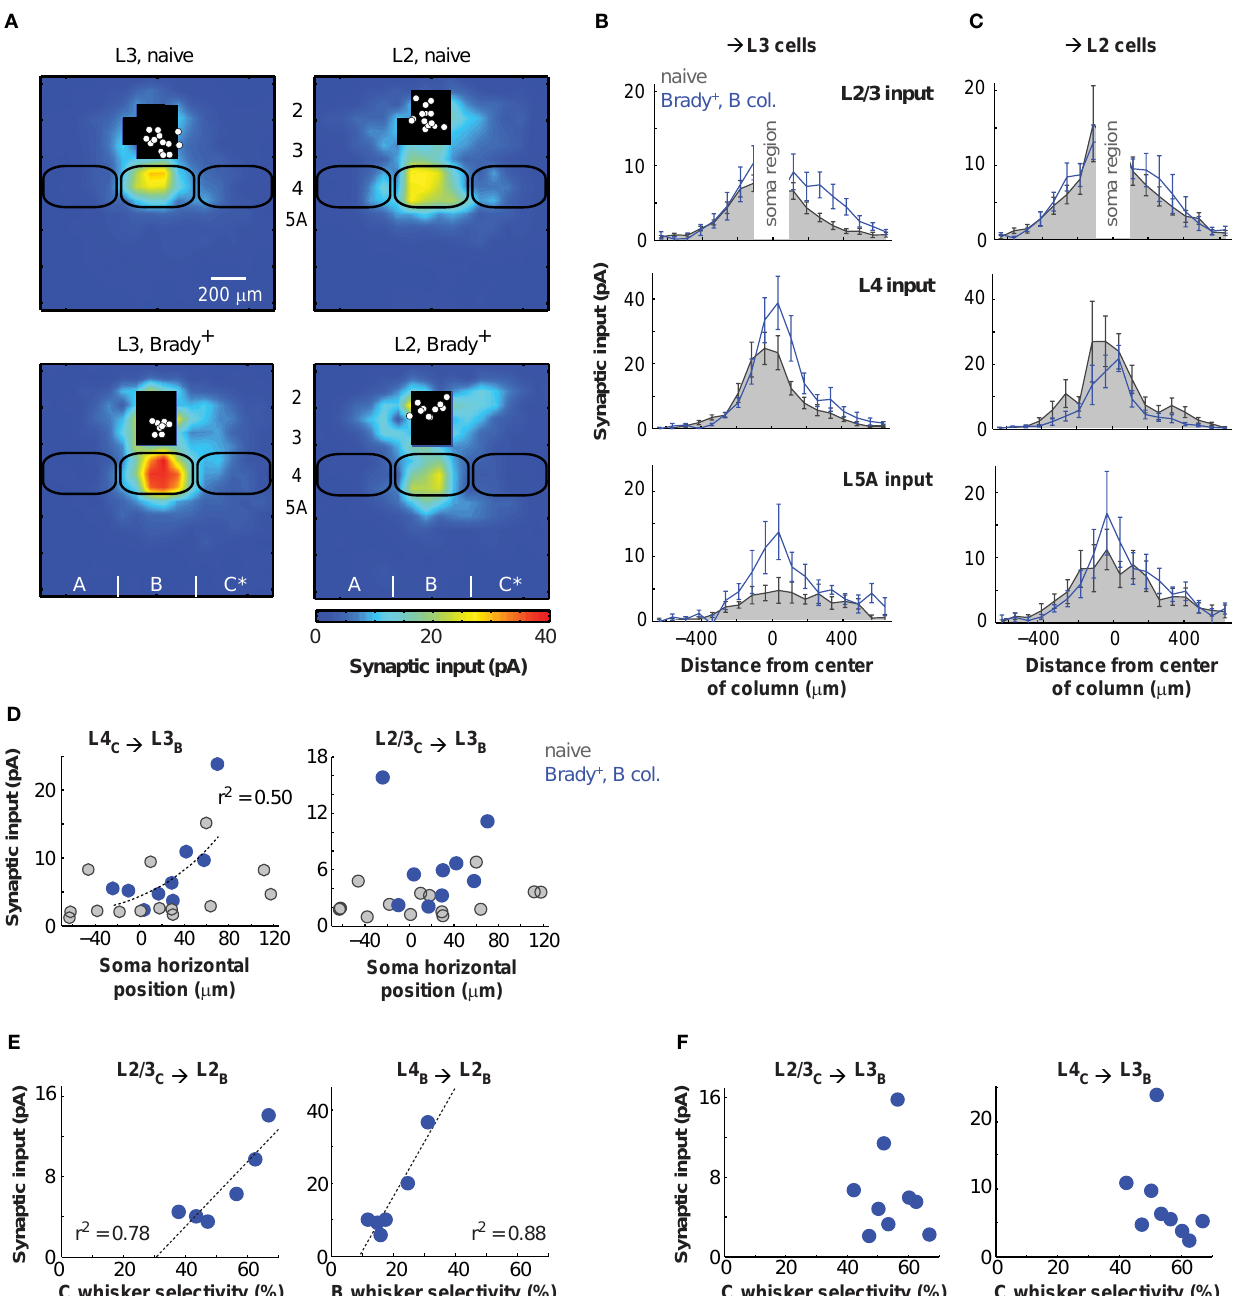
of transcolumnar L2/3 projections as a function of selectivity of the → L2 C B C-evoked cardiac responses (left) and strength of ascending L4 → L2 B B projections as a function of selectivity of the B-evoked cardiac responses (right). Each point corresponds to one mouse and averages the inputs of one to three cells. (F) Same as in E for L2/3 and L4 projections and the → L3 → L3 C B C B selectivity of C-evoked cardiac